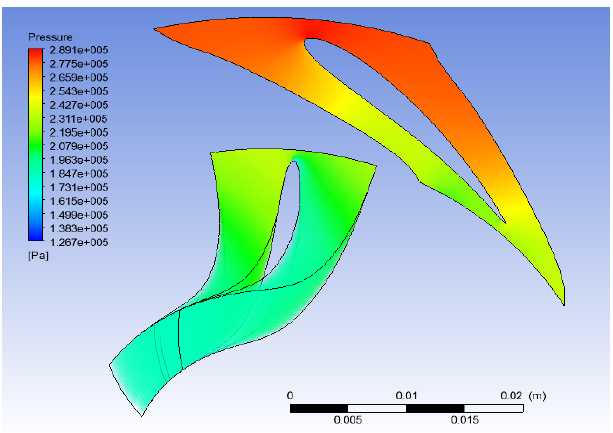
Figure 20. CFD study results: Pressure